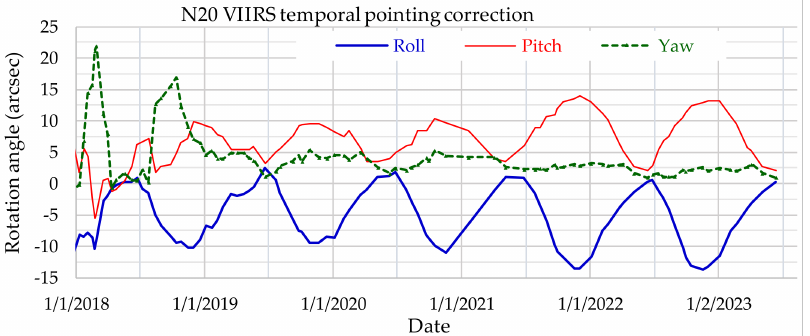
Figure 3. Temporal variations in pointing correction through additional instrument-to-spacecraft mounting interface rotation angles for SNPP VIIRS C2. The labels denote the known events that impacted geolocation. A: Side switch of VIIRS scan control electronics; B: Erroneous star tracker realignment; C: 1 s time error onboard of SNPP (213 arcsec pitch error) for 7 h; D: Star Tracker-2 reset; E and F: Forward processing with constant pointing correction.